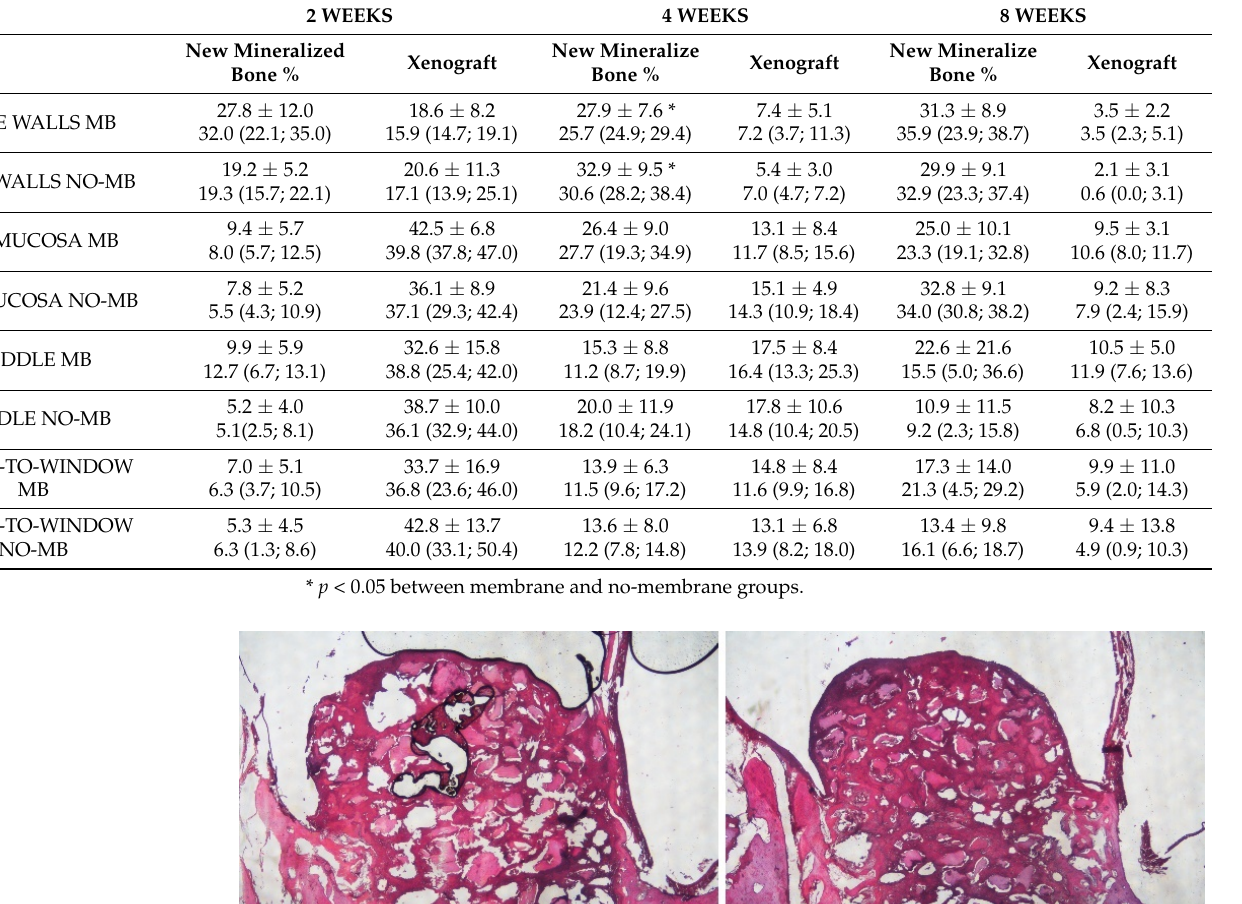
Table 2. Mineralized new bone and xenograft percentages (%) in the various regions evaluated after 2, 4, and 8 weeks of healing. Mean value ± standard deviation on the first line; median (25 and 75 percentiles) on the second line.